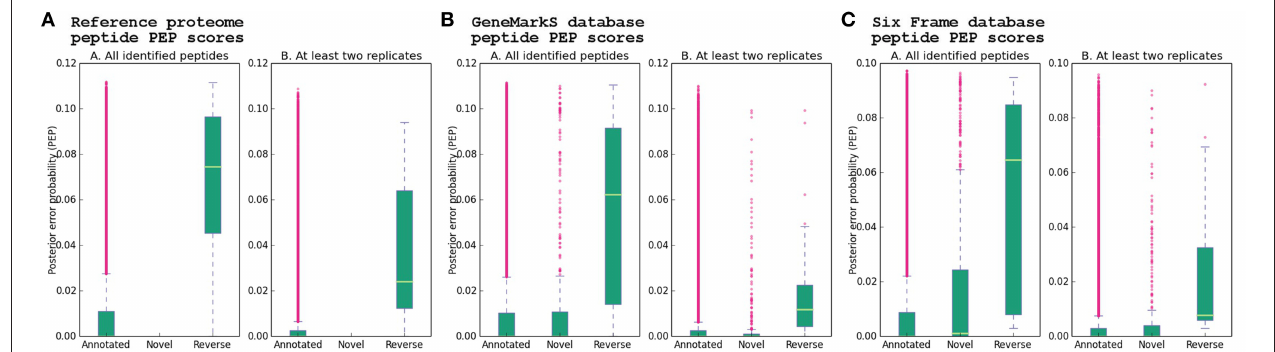
FIGURE 8 | Peptide PEP score distribution. The posterior error probability (PEP) score distribution of novel, annotated and reverse hit peptide identifications obtained using three different database searches are shown, using the PEP score of the best PSM obtained for every peptide, from the MaxQuant peptides.txt